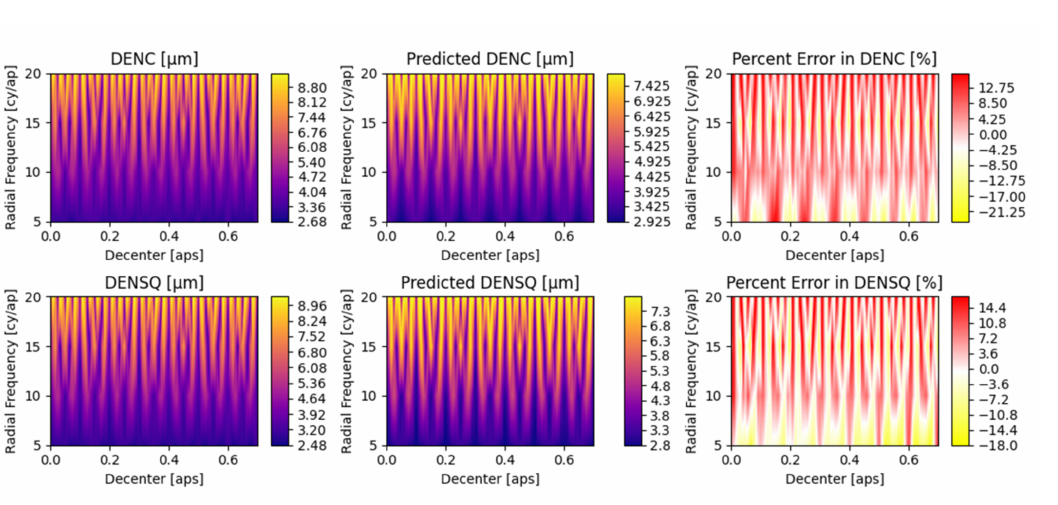
Figure A1. Decenter versus radial frequency. ( κ = ω = η = ζ = 0, σ = 0.05, θ = 0 ◦